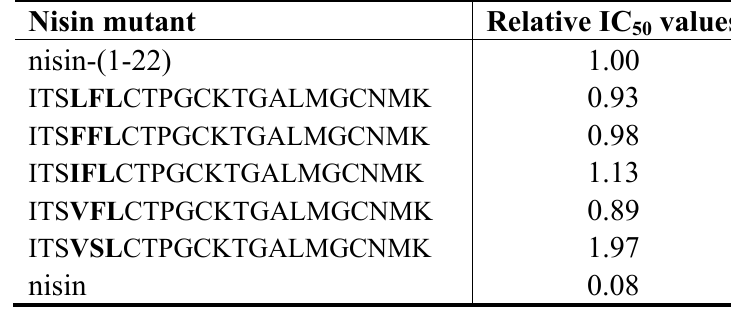
Table 2. Susceptibility of L. lactis LL108(pORI 280) cells to purified nisin and derived